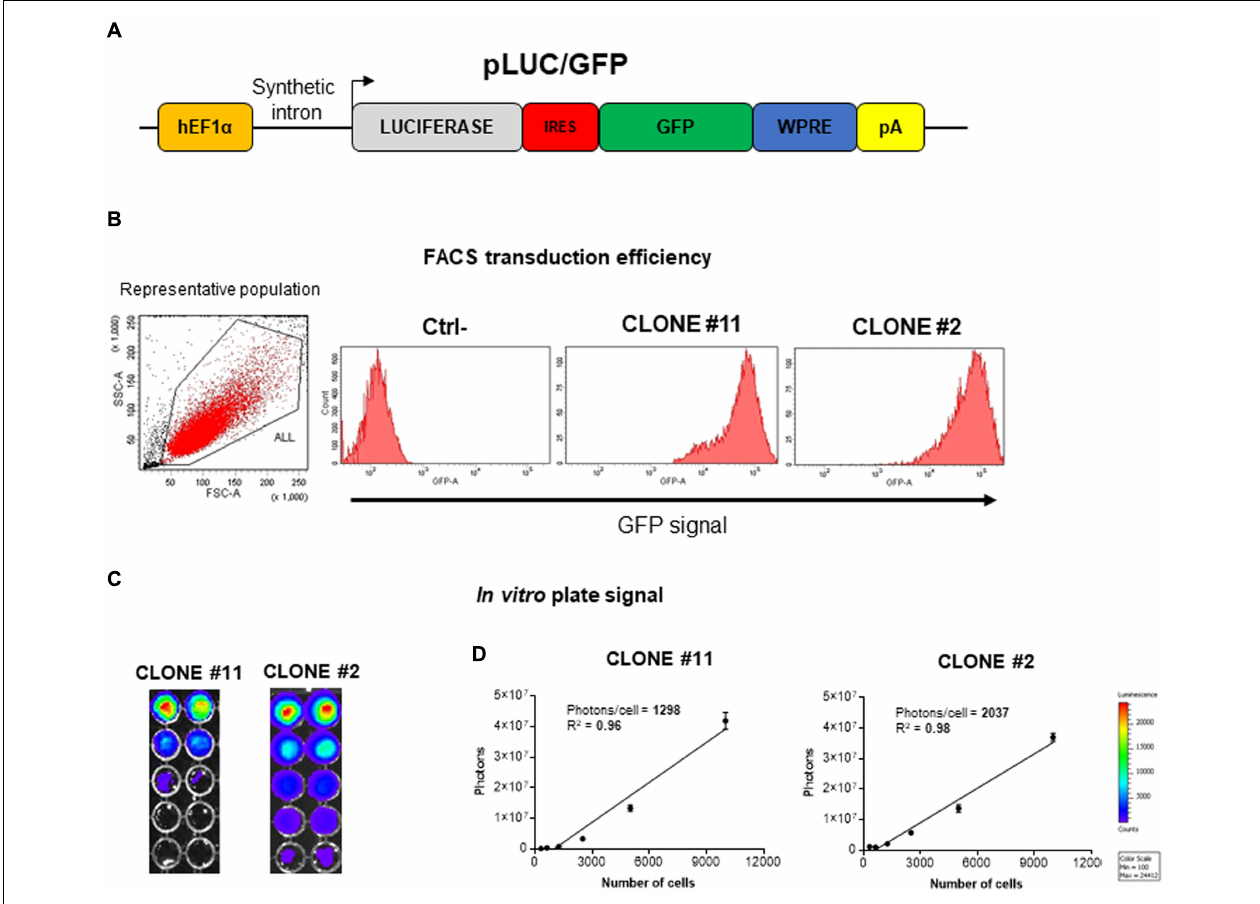
FIGURE 1 | Generation and in vitro characterization of stably transduced mouse bone marrow-derived mesenchymal stromal/stem cell (mBM-MSC) clones. (A) Schematic representation not to scale of the pLuc/GFP third-generation lentiviral construct carrying an expression cassette containing luciferase (Luc, colored in gray) and enhanced green fluorescent protein (EGFP, colored in green) open reading frames (ORFs) linked by an internal ribosome entry site (IRES, colored in red) sequence and transcriptionally regulated by human Elongation Factor 1 alpha (hEF1 α ) promoter, along with a synthetic intron. (B) Assessment of GFP expression by fluorescent activated cell sorting (FACS) analysis of clone #2 and #11Luc/GFP lentivirus-transduced mBM-MSCs. Non-transduced cells are used as negative control (Ctrl-). (C) In vitro titration of bioluminescence emission from clone #2 and #11 by In Vivo Imaging System (IVIS) bioluminescence imaging system. Clone #2 emits higher proton titers compared to clone #11. (D) Plot of linear correlation between total photon emission (in y axis) and cell numbers (in x axis). Quantification of photons emitted per single cell allowed the identification of clone #2 as the brighter